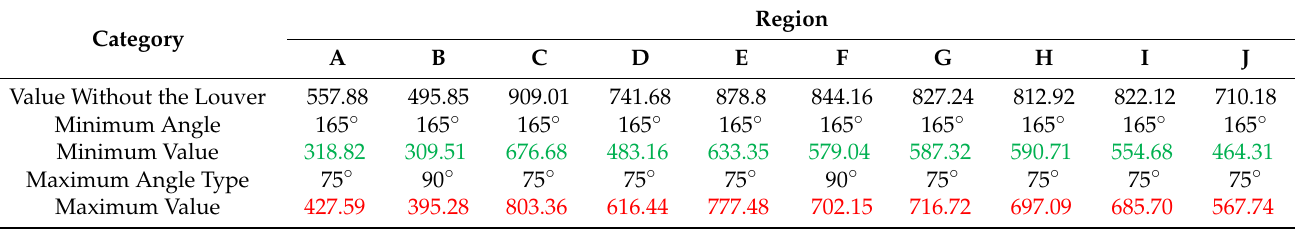
Table 6. Total thermal energy consumption in summer.